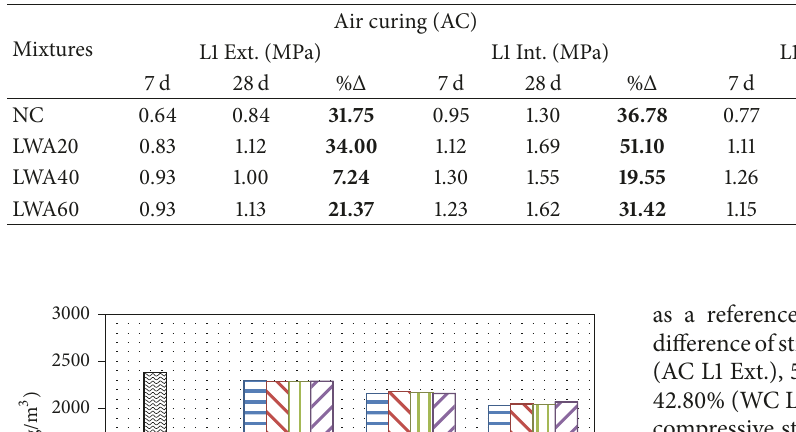
Table 4: Differential percentage of minute compressive strength in layer 1 (L1) between 7 and 28 days of age.